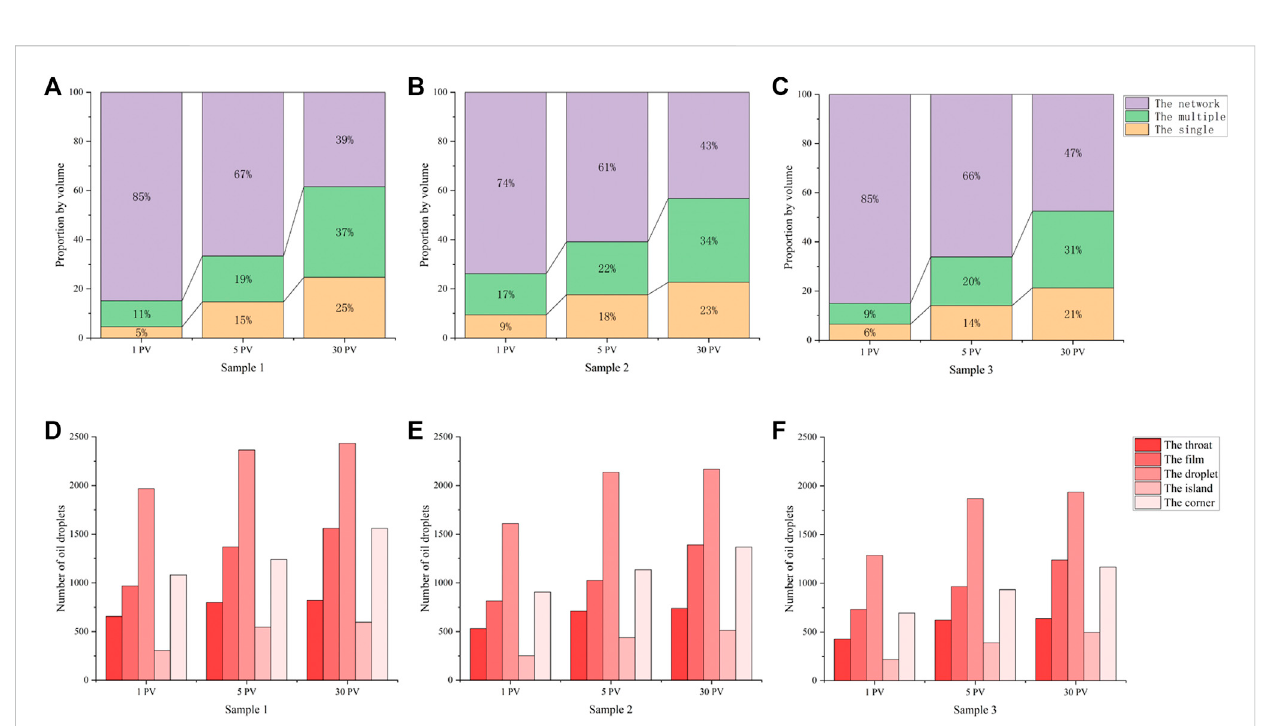
FIGURE 4 Changes in micro-remaining oil during water fl ooding. (A – C) Changes in the volume proportion of the network, the multiple, and the single. (D – F) Changes in throat, fi lm, droplet, island, and corner